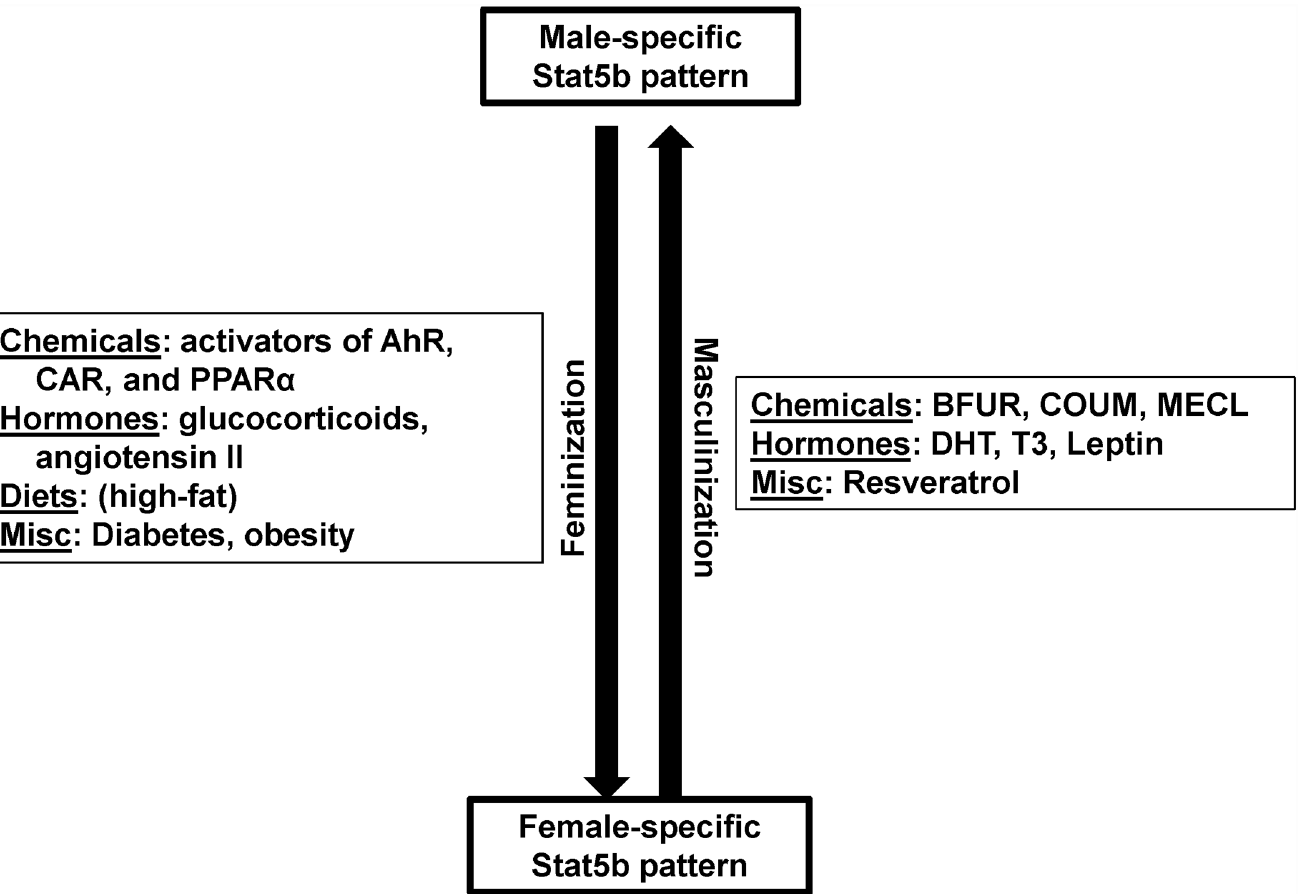
Fig 7. Summary of factors identified in this study that masculinize or feminize the liver transcriptome. Not all high fat diets caused feminization indicated as a parentheses around “ high fat ” . Abbreviations: BFUR, benzofuran; COUM, coumarin; MECL, methylene chloride; DHT, dihydrotestosterone; GH, growth hormone; T3, thyroid